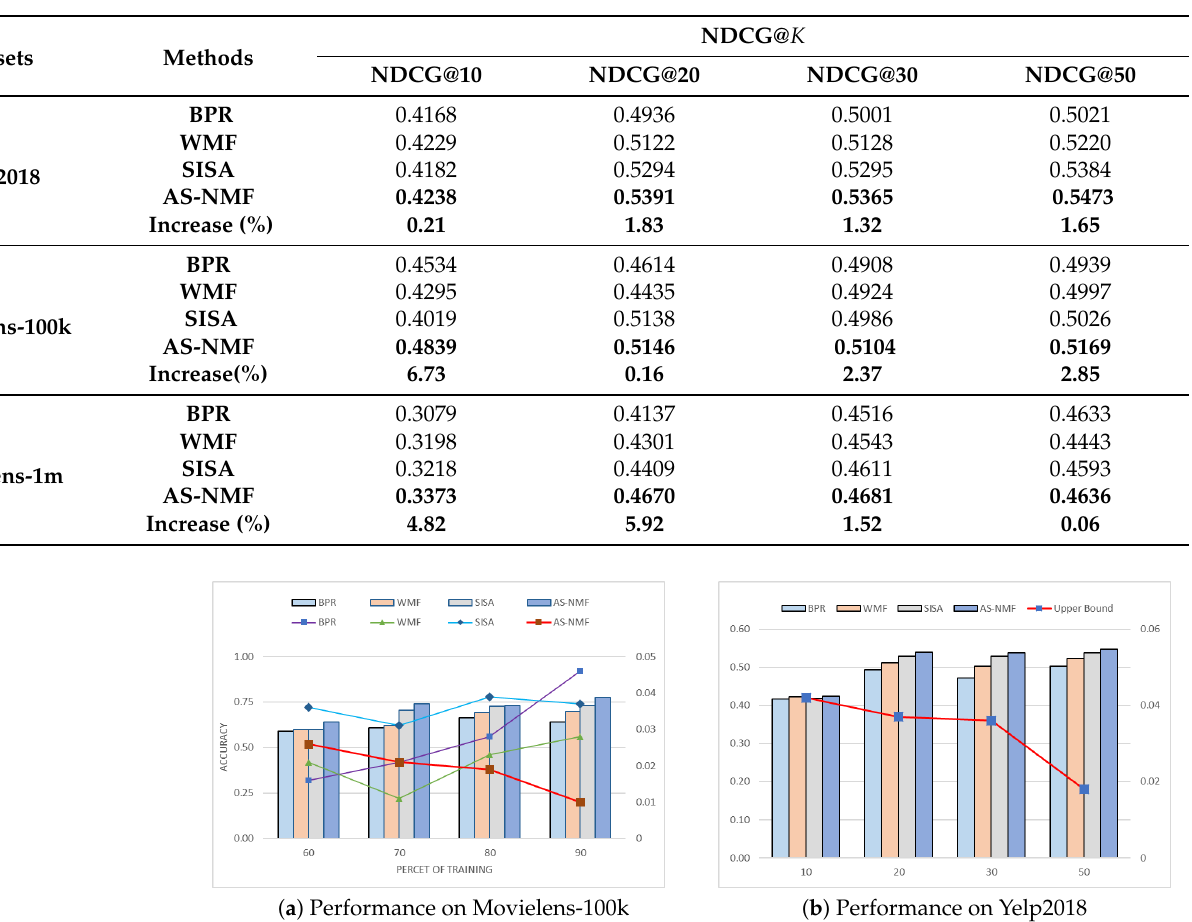
Table 3. Comparison of NDCG@ K for different recommendation methods. The proposed AS-NMF method is tested with a different data partition in this Table. The best results and improvements are highlighted in bold.